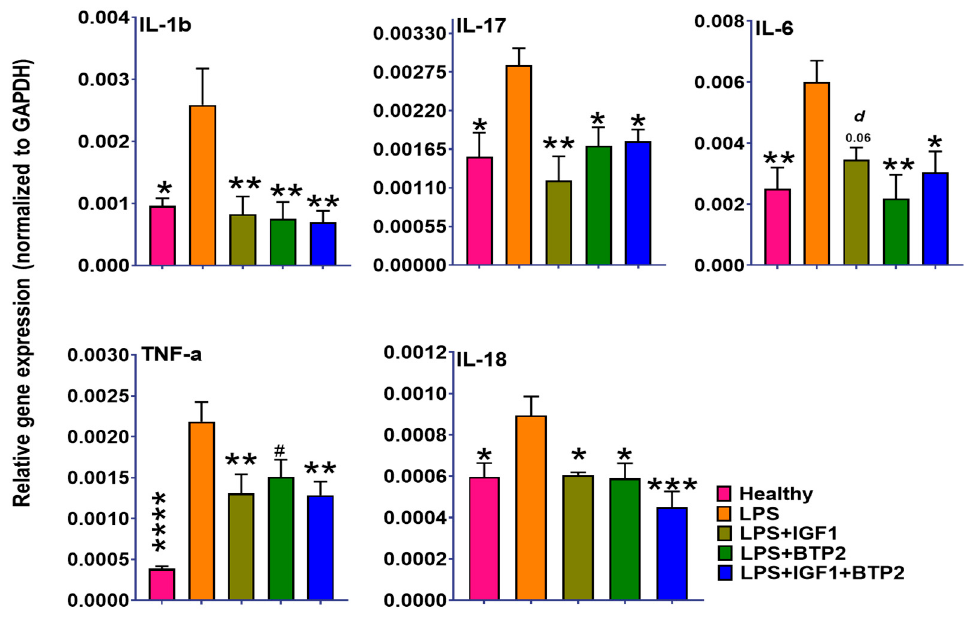
Figure 5. Favorable effects of IGF-1, BTP-2 monotherapies, and IGF-1 + BTP-2 combination therapies on LPS induced AKI associated major proinflammatory cytokines within the kidney. See text for interpretation. Data are mean ± SEM * p < 0.05, ** p < 0.01, *** p < 0.001, **** p < 0.0001, # not